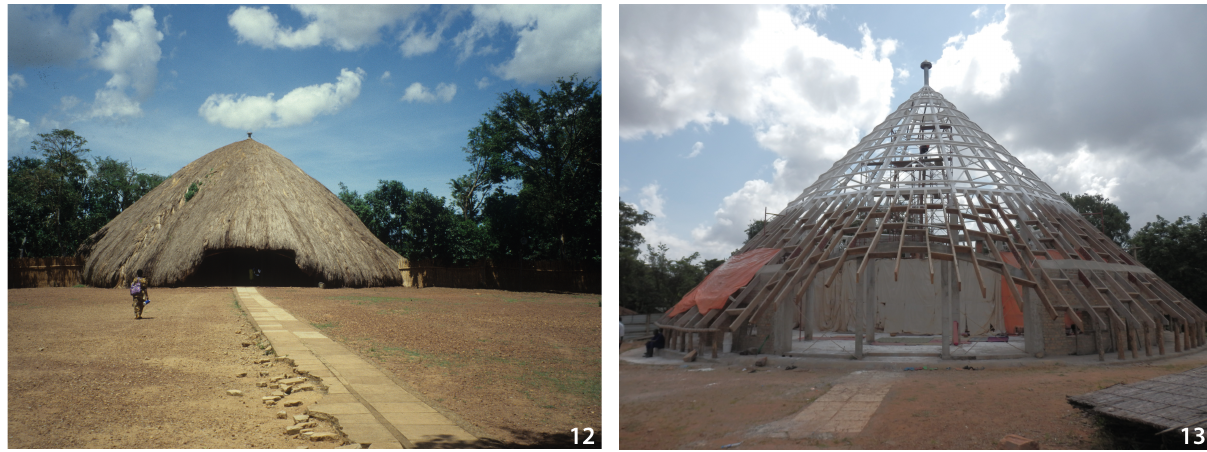
Figure 12 Kasubi Tomb, Uganda (Source: Joseph King). Figure 13 Kasubi Tomb, being restored after destruction (Source: Joseph King).